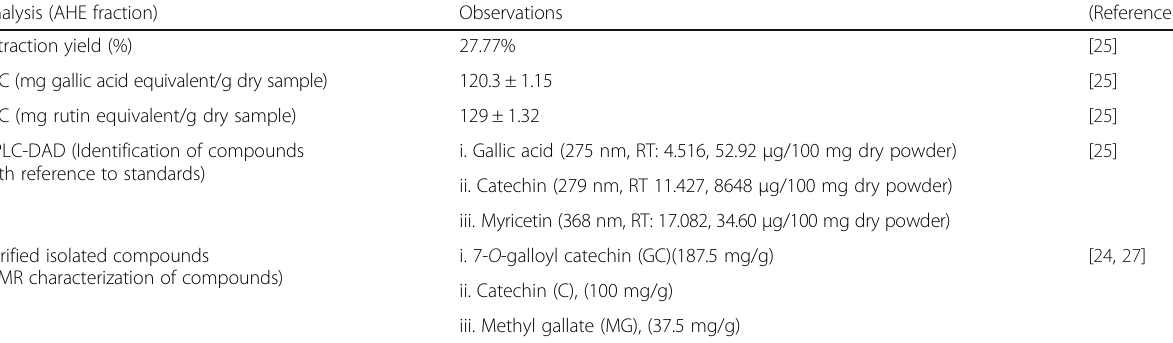
Table 1 Extraction yield, TPC, TFC, and chemical constituents in A. hydaspica ethyl acetate extract (AHE) Analysis (AHE